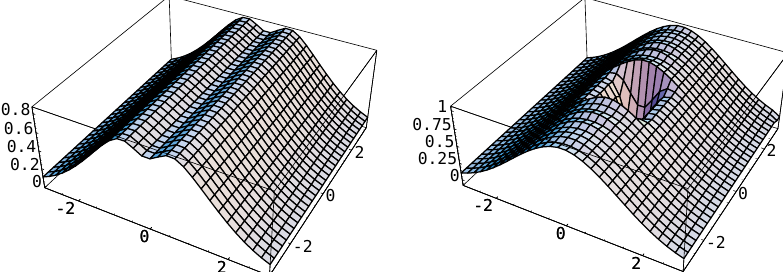
FIG. 35. (Color) Phase space distributions. Left: distribution c 0 with trench. Right: c 0 1 c 1 hole but no ridge.